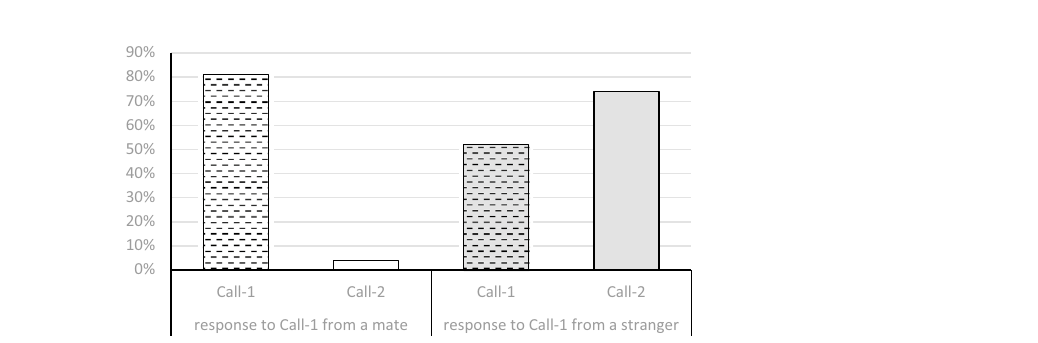
Figure 4. The response of paired individuals to the playback of Call-1 from their mate (white bars) and from a stranger (grey bars). The response of tested individuals with Call-1 is presented using hatched bars and with Call-2 using plain